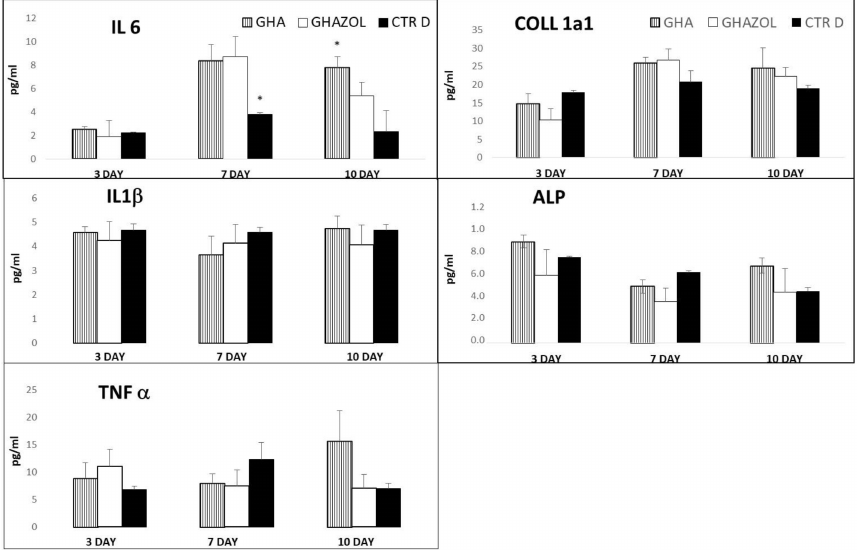
Figure 7. Cytokine and bone-related protein release. Evaluation of pro-inflammatory growth factors, Interleukin 6 (IL6), Interleukin 1 beta (IL1 β ), Tumor Necrosis Factor alpha (TNF α ) and main bone markers, Collagen alpha-1(I)chain (COLL1a1) and Alkaline Phosphatase (ALP) secreted by the 3D fracture models in the culture medium and assayed by immunoenzymatically tests after 3, 7, and 10 days of culture. Data are reported as mean ± standard deviation (*: p <